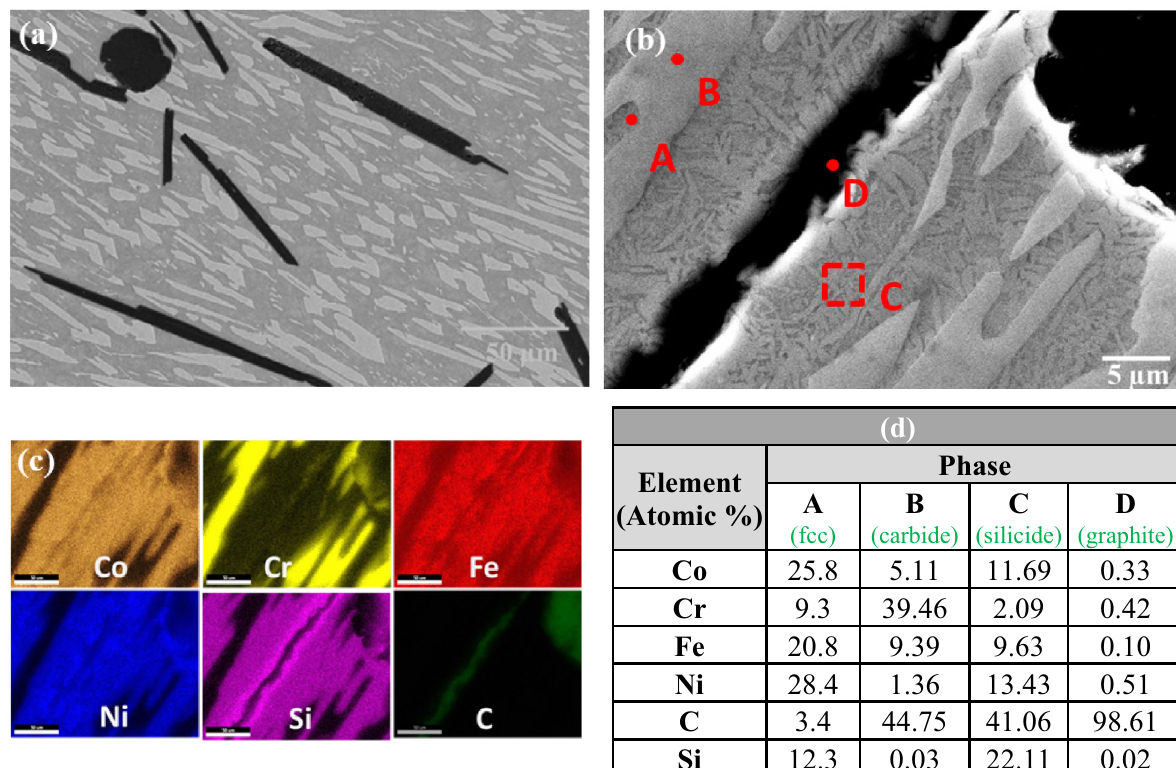
Figure 6. ( a ) SEM image of sample S-5, ( b ) magnified view, ( c ) elemental mapping, and ( d ) EDS results at the indicated